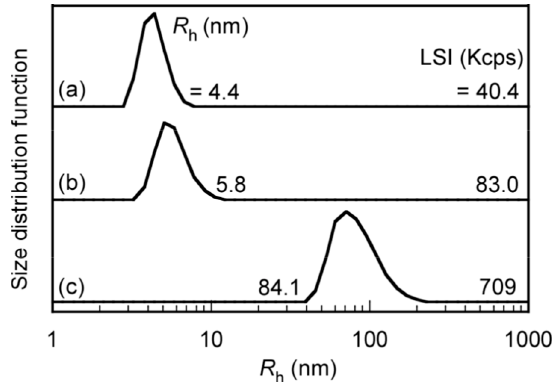
Figure 5. Hydrodynamic-radius ( R h ) distributions for (a) PEG 54 -PAA 140 , (b) PEG 54 -P(AA/VE35) 140 , and (c) PEG 54 -P(AA/VE6/ γ TCP29) 140 in PBS at C p = 0.10